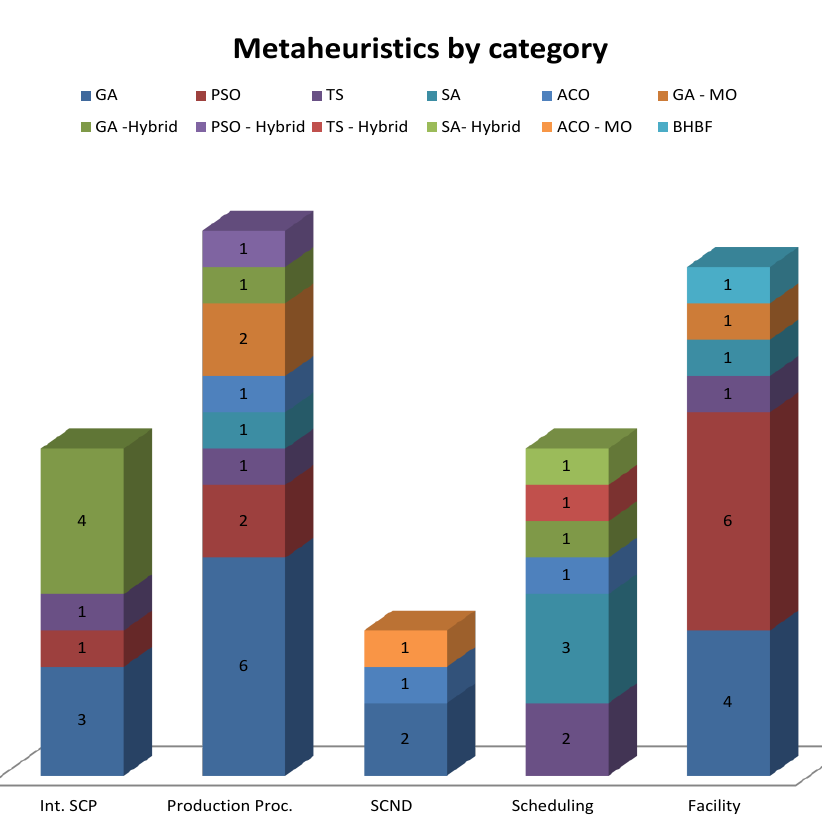
Figure 5. Metaheuristics by